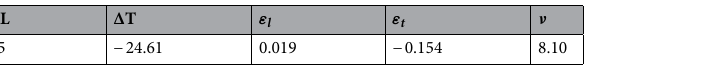
Table 6. Measured displacements, strains and Poisson’s ratio of honeycomb composite in the case of tensile test.